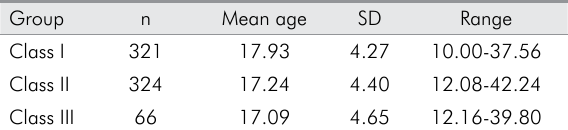
Table 1. Descriptive statistics of the initial ages of the groups evaluated.